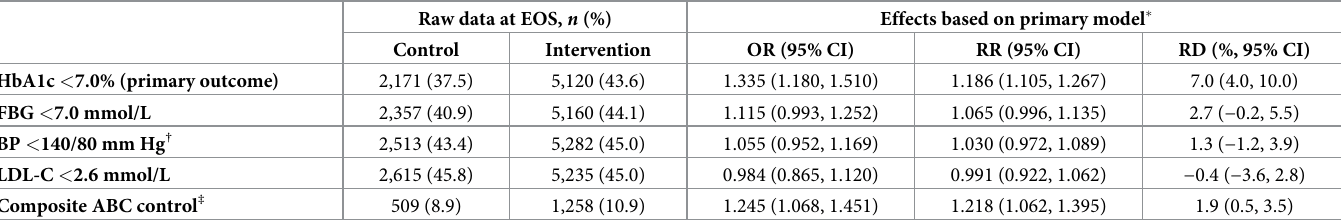
Table 2. Estimated effects of intervention compared with control on primary and secondary outcomes, with binary outcomes.